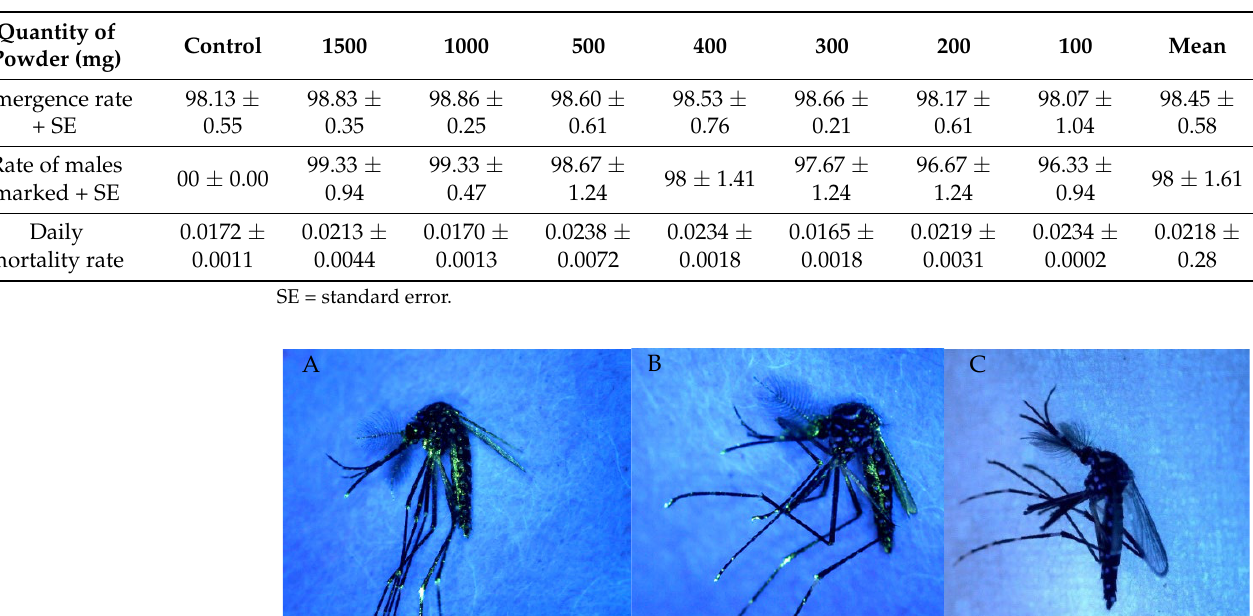
Table 2. Mixed-effect binomial model of male Aedes aegypti survival in function of fluorescent powder